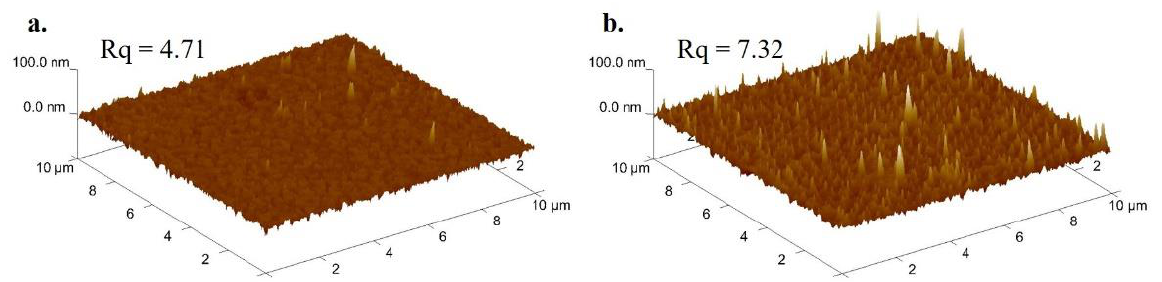
Figure 3. Atomic force microscopy (AFM) surface roughness profiling of ( a ) billowy gold nanostructure (BGN) and ( b ) gold nanoframe array (GNA) structures.